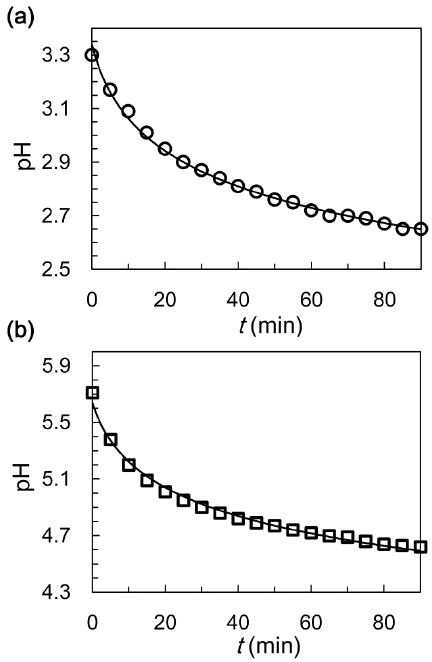
Figure 2. pH decrease induced by the hydrolysis of GDL. The pH variation process of aqueous solution with GDL (2%, w/v ) ( a ) and the one with sodium alginate (2%, w/v ), EDTA-Ca (0.1 M) and GDL (2%, w/v ) ( b ).